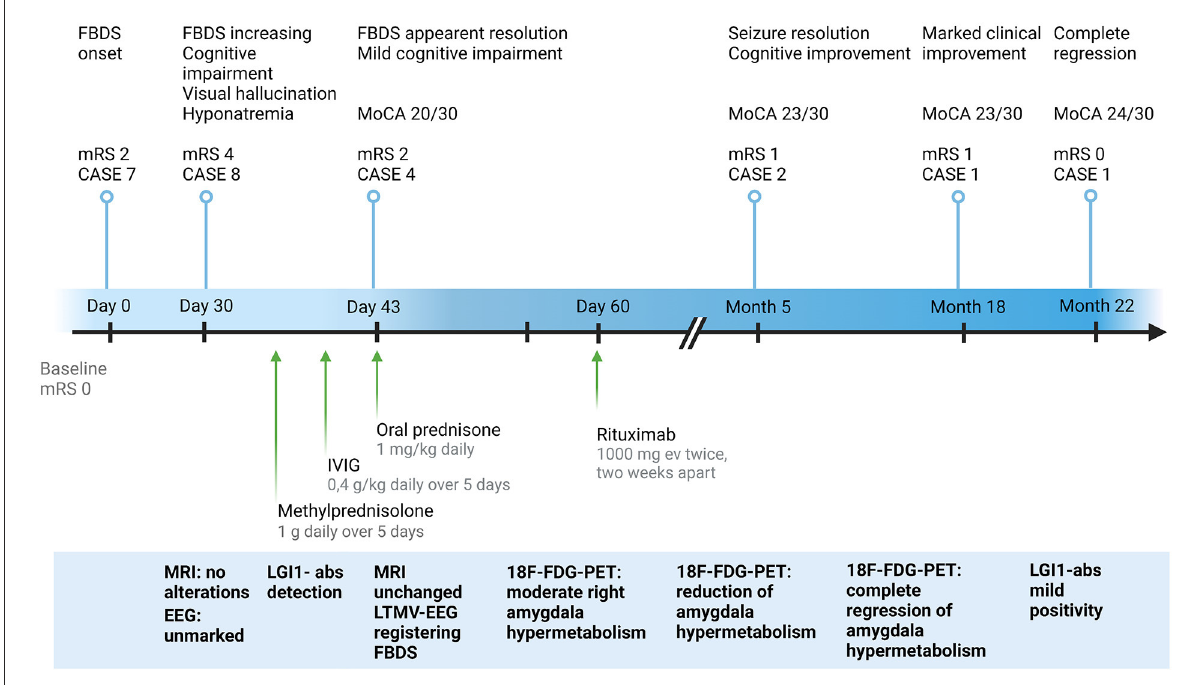
FIGURE1 Clinical and paraclinical features of the study case from symptoms onset to last follow-up. CASE, Clinical Assessment Scale in autoimmune Encephalitis; EEG, electroencephalography; 18F-FDG-PET, 18F-fluoridesoxyglucose-positron emission tomography; FBDS, faciobrachial dystonic seizures; IVIG, intravenous immunoglobulins; LGI1-abs, leucine-rich glioma-inactivated protein 1 antibodies; LTMV-EEG, long-term-monitoring video electroencephalography; MoCA, Montreal Cognitive Assessment; MRI, magnetic resonance imaging; mRS, modified Rankin Scale. Created with BioRender.com.